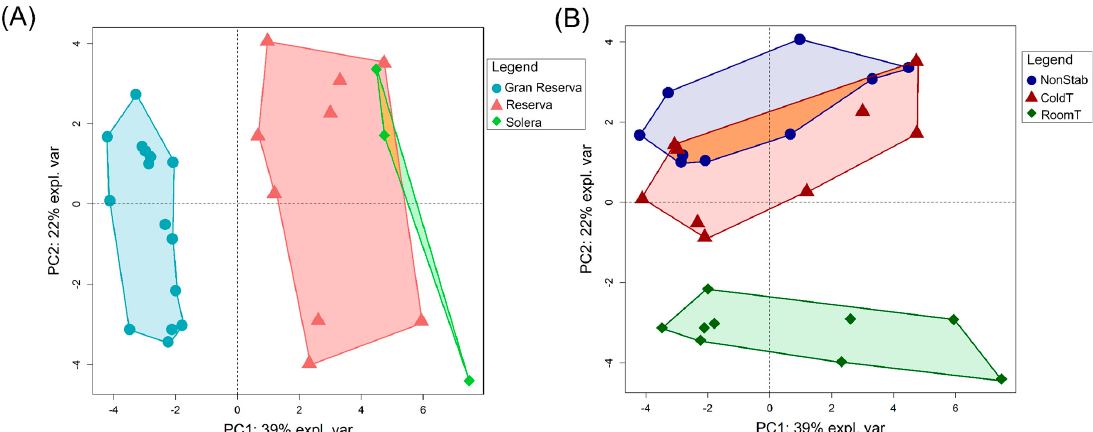
Figure 1. Principal component analysis (PCA) carried out on the brandy samples. Scores plot for the first two principal component highlighting brandies according to the ageing factor ( A ), and before and after cold stabilization and filtration treatment ( B ). NonStab: non-stabilized brandy; ColdT: brandy stabilized at cold temperature; RoomT: brandy stabilized at room temperature.